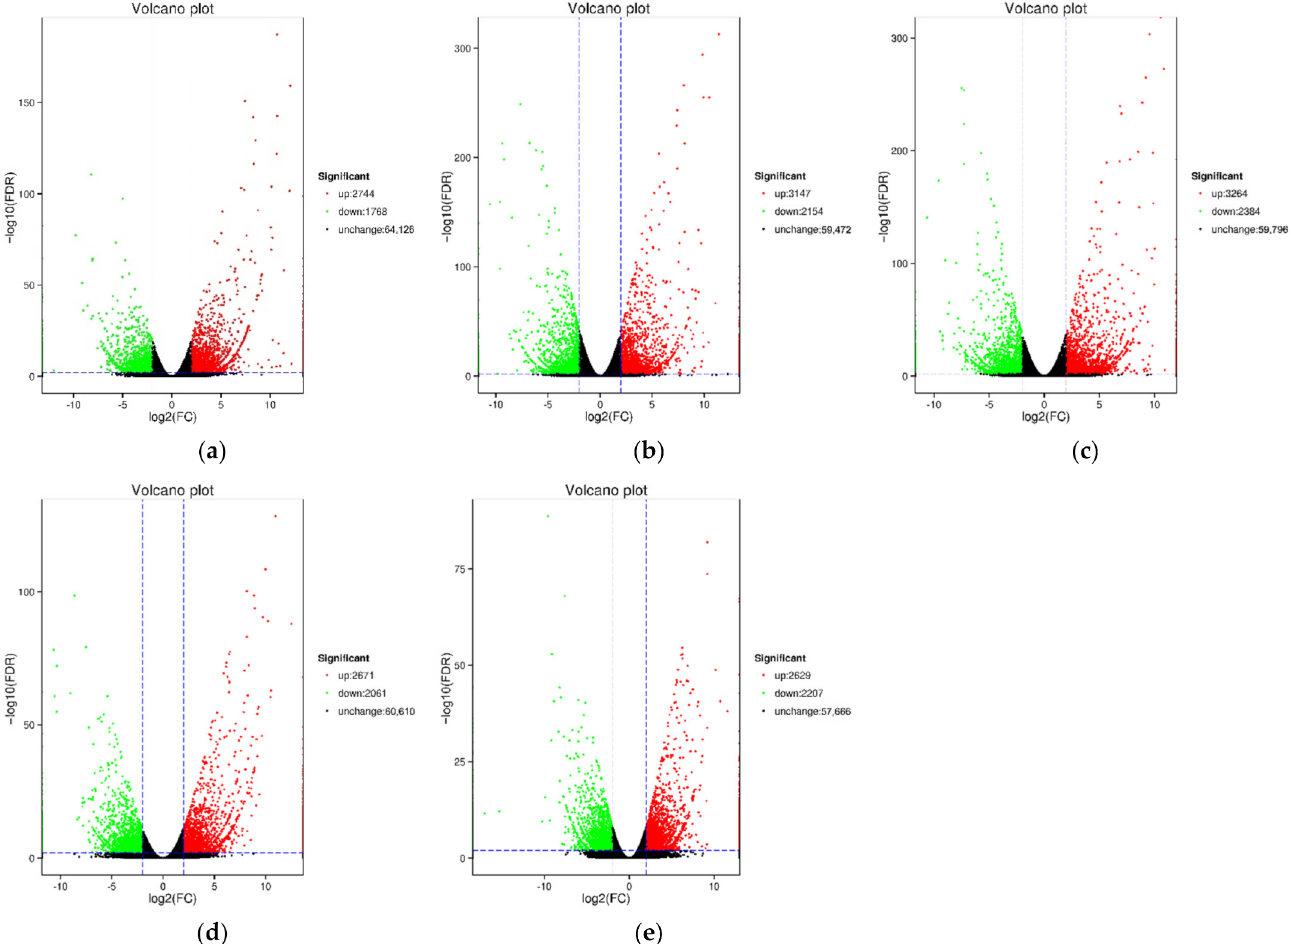
Figure 4. Volcano plots of DEGs in different groups. ( a ) H1 vs. B1; ( b ) H2 vs. B2; ( c ) H3 vs. B3; ( d ) H4 vs. B4; ( e ) H5 vs. B5. Each point in the differential expression volcano plot represents a gene, and the abscissa represents the logarithm of the fold difference in expression of a certain gene between the two samples. The larger the absolute value, the greater the fold difference of the expression level between the two samples. The ordinate represents the negative logarithm of the false discovery rate. The larger the value, the more significant the differential expression, and the more reliable the differentially expressed genes obtained by screening. Red and green dots represent up-regulated and down-regulated DEGs, respectively. Black dots represent unchanged